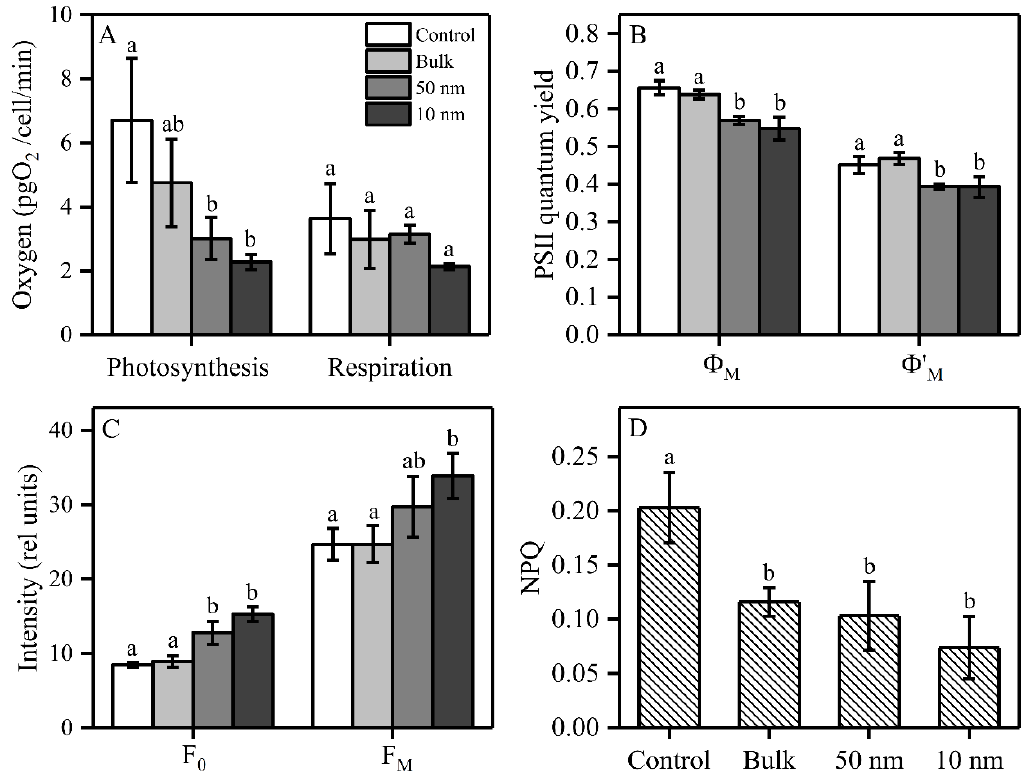
Figure 2. Effects of three sizes of TiO 2 on photosynthetic parameters in S. obliquus after 72 h exposure. ( A ) Oxygen evolution/consumption under growth light and dark conditions, respectively; ( B ) PSII quantum yield; ( C ) Maximal and minimal fluorescence yields (F M and F 0 ); and ( D ) non-photochemical quenching (NPQ). Different letters on the error bars represent significant (Tukey’s HSD, p < 0.05) differences. Values are represented as means ± SD ( n = 3).